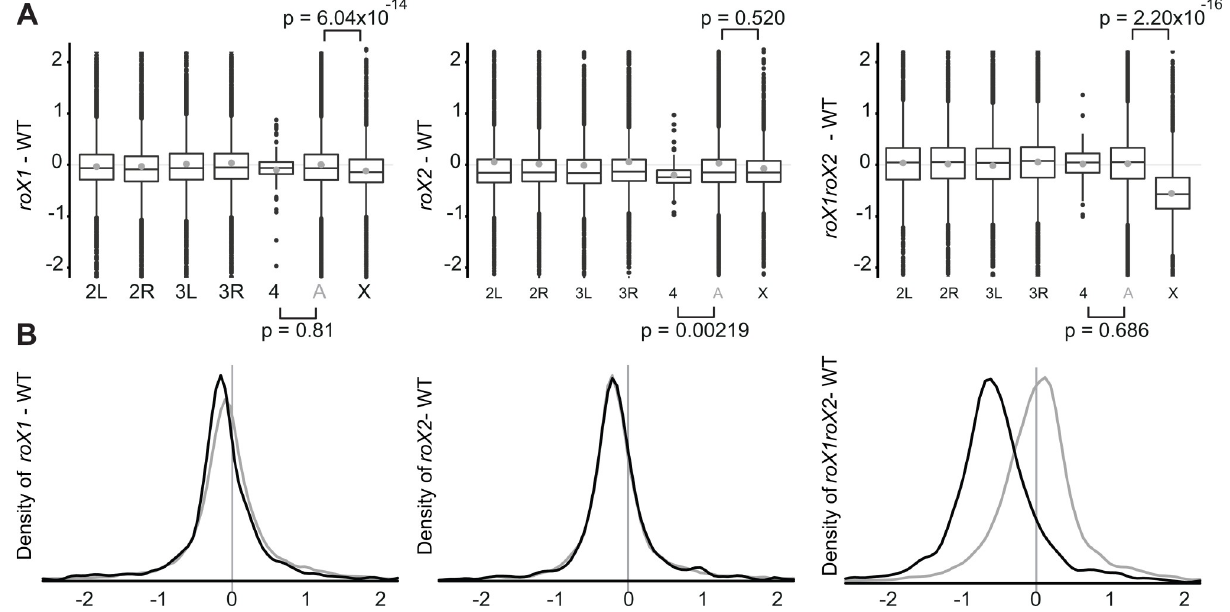
Fig 3. roX RNAs are required for proper transcription of genes on the 4 th and X-chromosomes. (A) Boxplots representing distributions of expression ratios for individual chromosome arms and chromosomes 2 and 3 combined (light grey A). The grey dots represent means of the samples. (B) Density plots of expression ratios for the X chromosome (black) and chromosomes 2 and 3 combined (grey). The vertical bar indicates the 0.